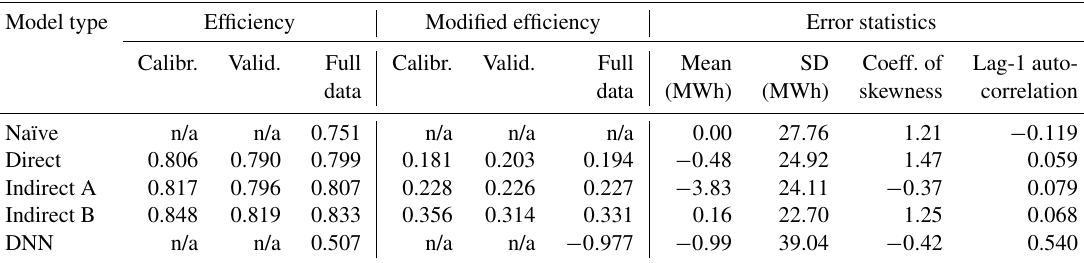
Table 2. Comparison of different forecasting schemes.